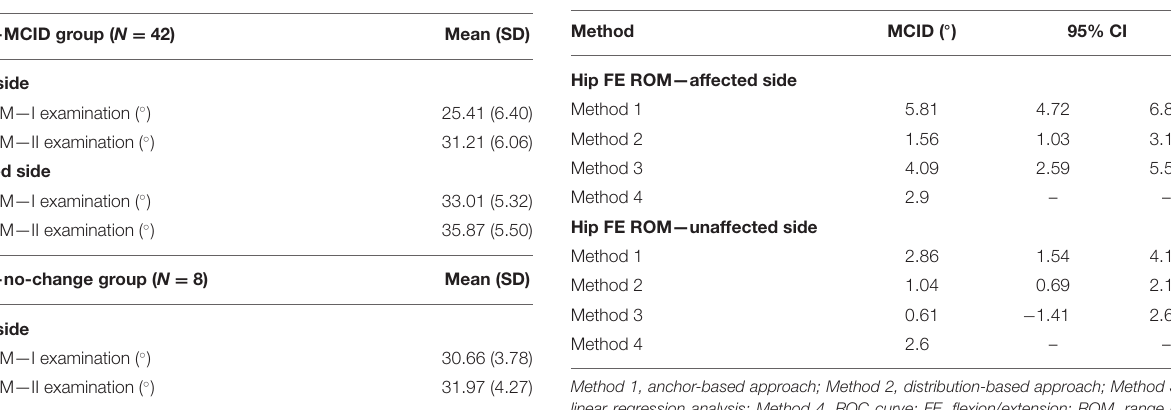
TABLE 3 | MCID identified using four approaches for hip FE ROM—affected/unaffected